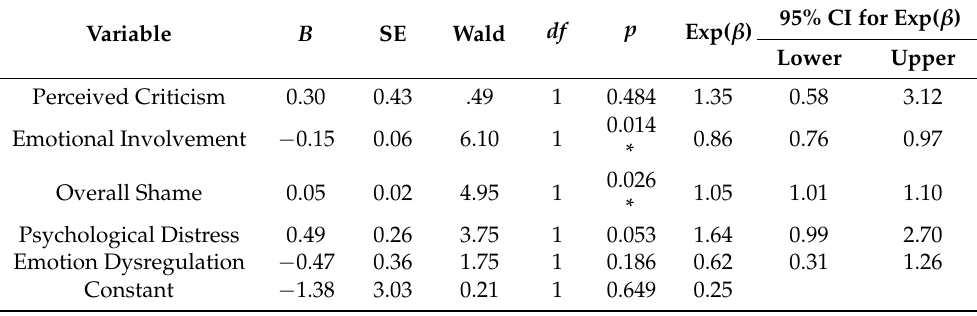
Table 4. Logistic regression differentiating current from previous